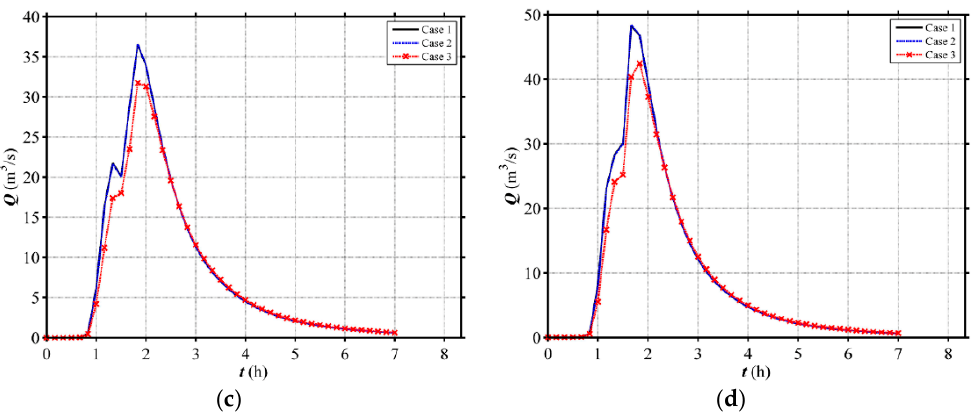
Figure 22. Simulated hydrographs at the outlet for different land use scenarios of Wangmaogou